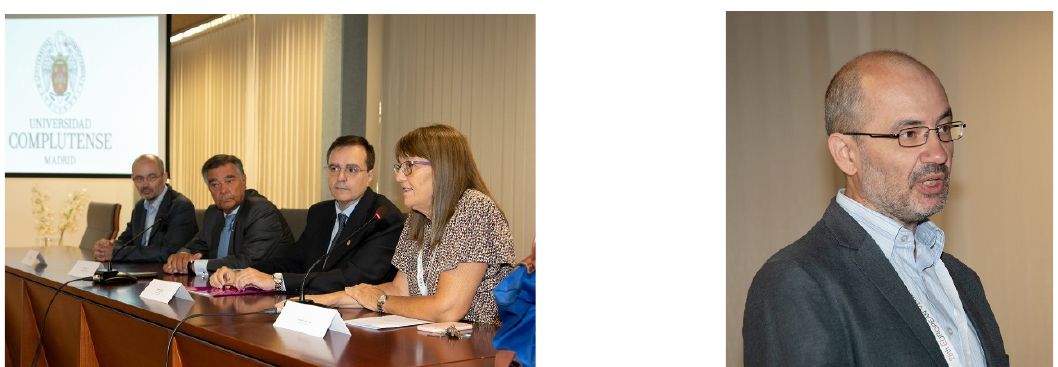
Figure 1. The Opening Ceremony. From left to right: Milan Chytry, general secretary of EVS (European Vegetation Survey); Luis González Díaz, president of Madrid Official Professional Pharmacy College; Manuel Córdoba, the Pharmacy Faculty vice-dean on behalf of the Dean, Irene Iglesias, and Rosario G. Gavilán, chair of the Organizing Committee. Right: Milan Chytry introducing EVS features in the Opening Ceremony.